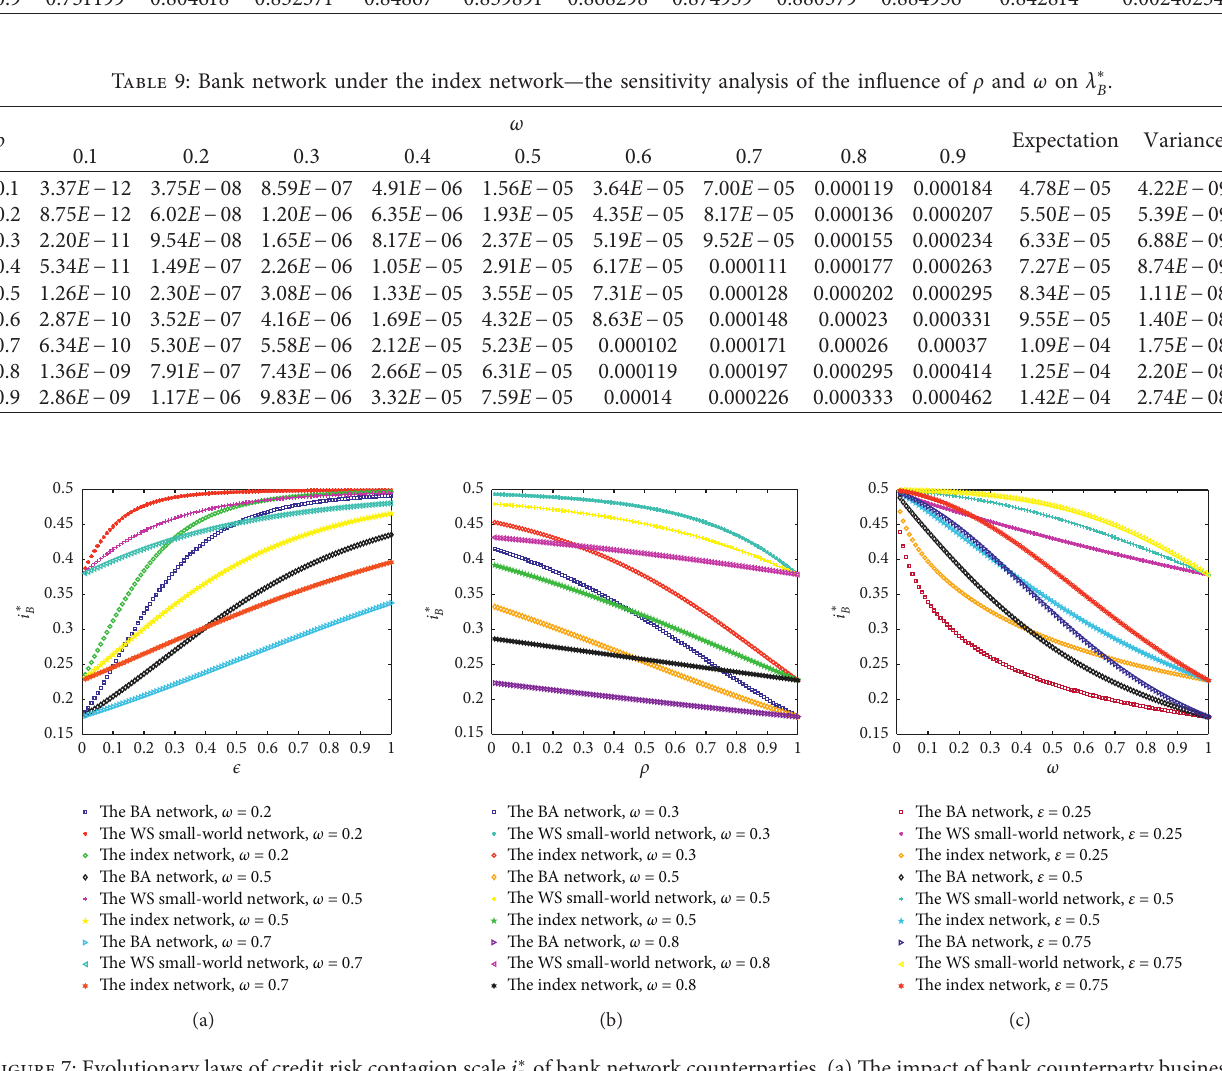
Figure 7: Evolutionary laws of credit risk contagion scale i ∗ B of bank network counterparties. (a) The impact of bank counterparty business association degree ε on i ∗ B in the bank network under different network structures and different bank counterparty risk resistance abilities ω . (b) The impact of the bank’s counterparty risk information processing ability ρ on i ∗ B in the bank network under different network structures and different bank counterparty risk resistance abilities ω . (c) The impact of bank counterparty risk resistance ability ω on i ∗ B in the bank network under different network structures and different bank counterparty business correlations ε